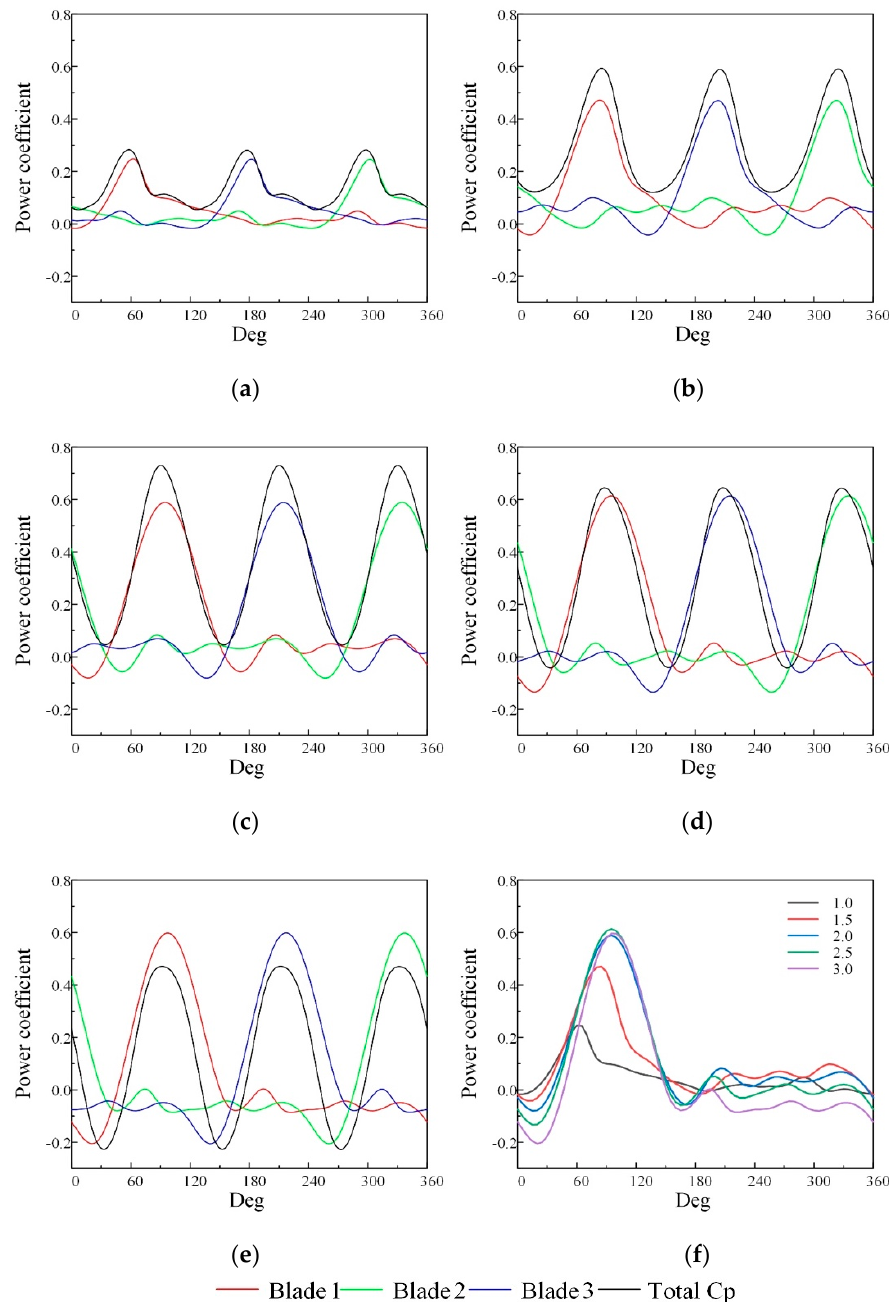
Figure 6. Power coe ffi cient in di ff erent λ . ( a ) Power coe ffi cient in λ = 1.0. ( b ) Power coe ffi cient in Figure 6. Power coefficient in different λ . ( a ) Power coefficient in λ = 1.0. ( b ) Power coefficient in λ = λ = 1.5. ( c ) Power coe ffi cient in λ = 2.0. ( d ) Power coe ffi cient in λ = 2.5. ( e ) Power coe ffi cient in λ = 3.0. 1.5. ( c ) Power coefficient in λ = 2.0. ( d ) Power coefficient in λ = 2.5. ( e ) Power coefficient in λ = 3.0. ( f ) ( f ) Power coe ffi cient of each Power coefficient of each blade.